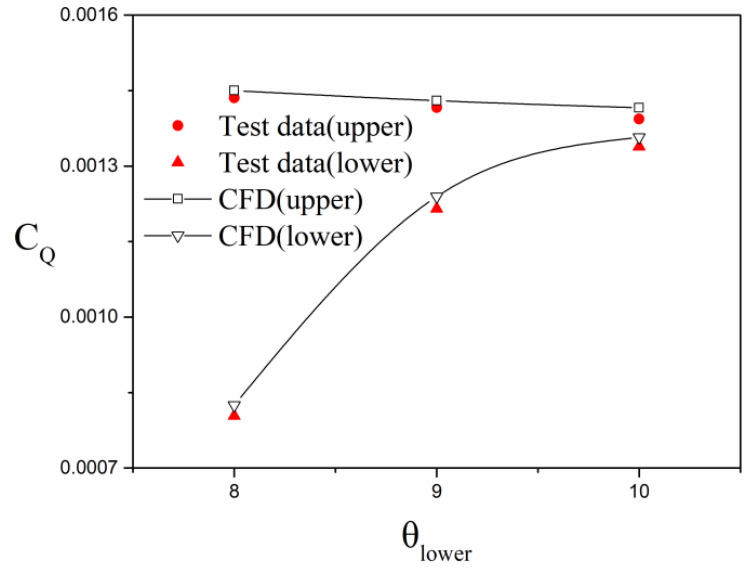
Figure 15. The moment coefficient of the upper and lower rotors varies with the collective pitch of the lower rotor.